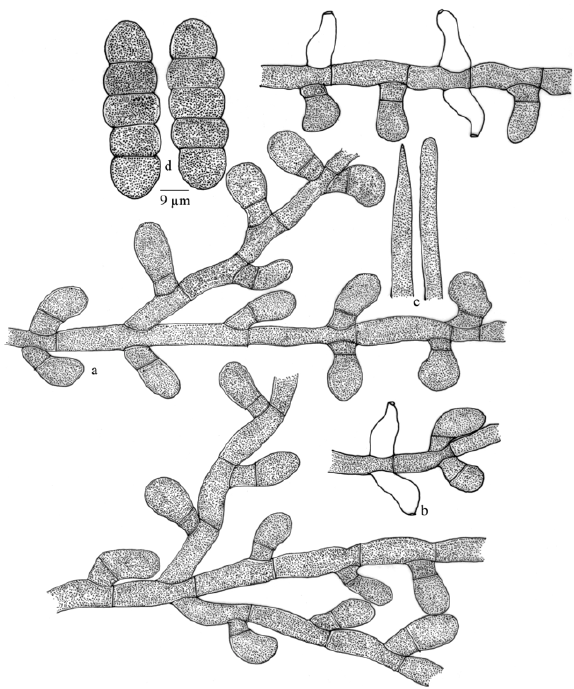
Figure 45. Meliola ardisiigena a - Appressorium; b - Phialide; c - Apical portion of mycelial setae; d - Ascospores